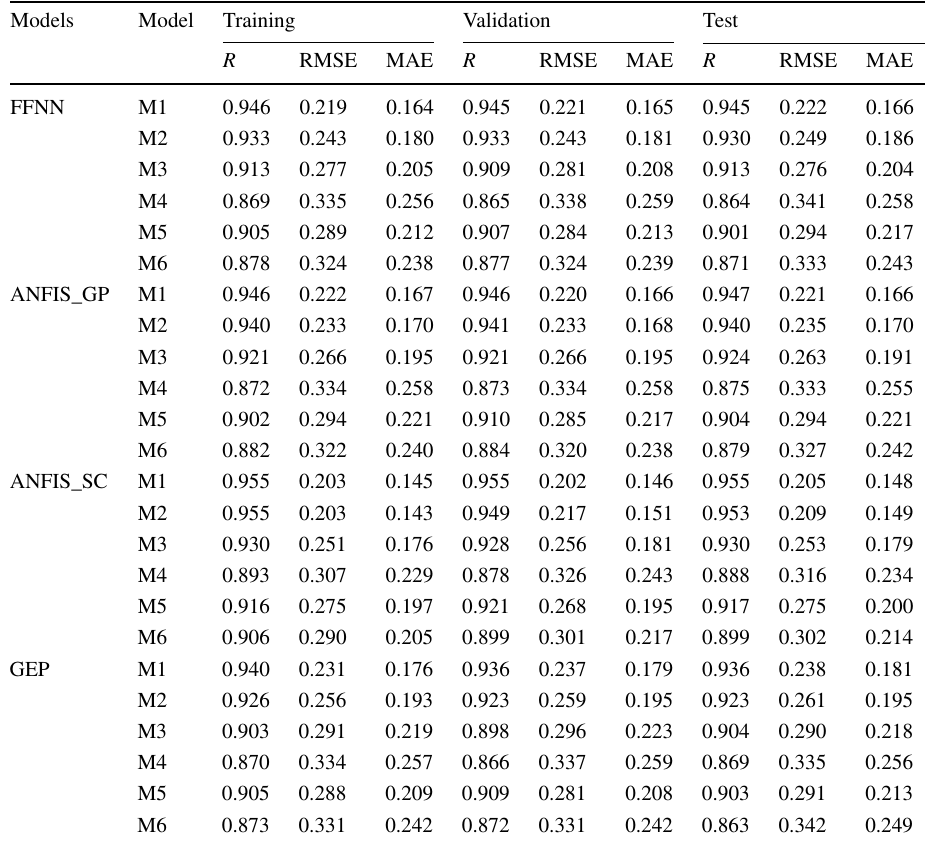
Table 6 Performances of the FFNN, ANFIS_SC, ANFIS_GP and GEP models in different phases for USGS 06892350 station